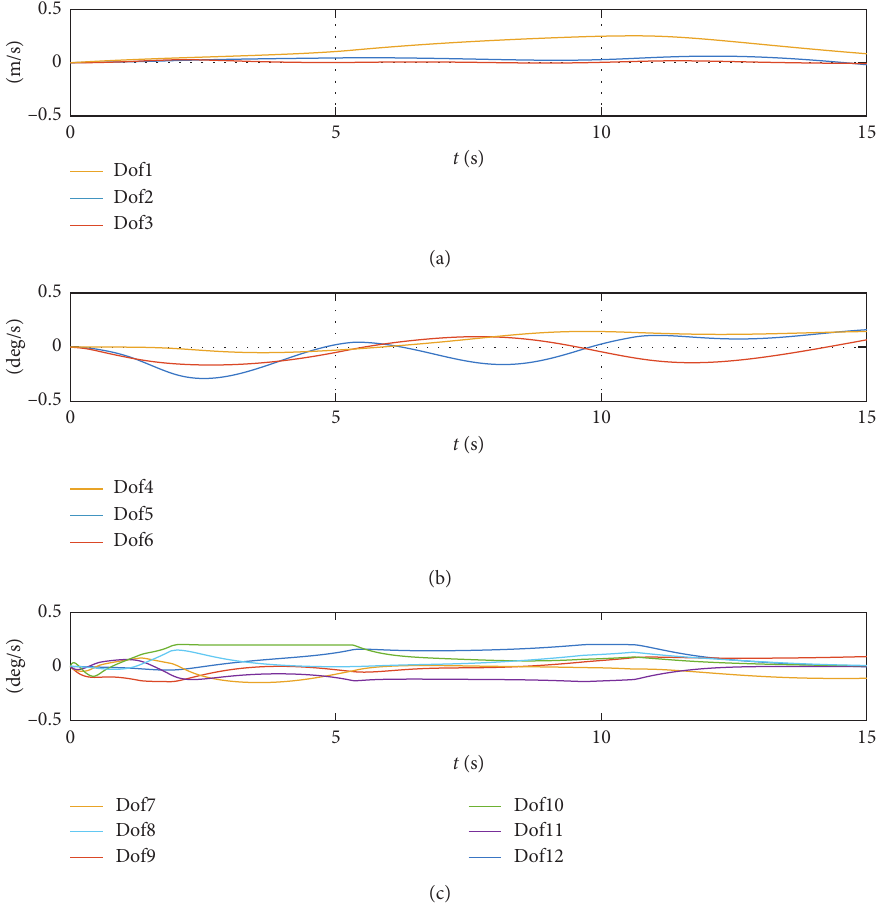
Figure 11: Tracking process comparison of the UVMS by (a) the proposed method, (b) SMC, (c) PID, and (d) H Kleinman.